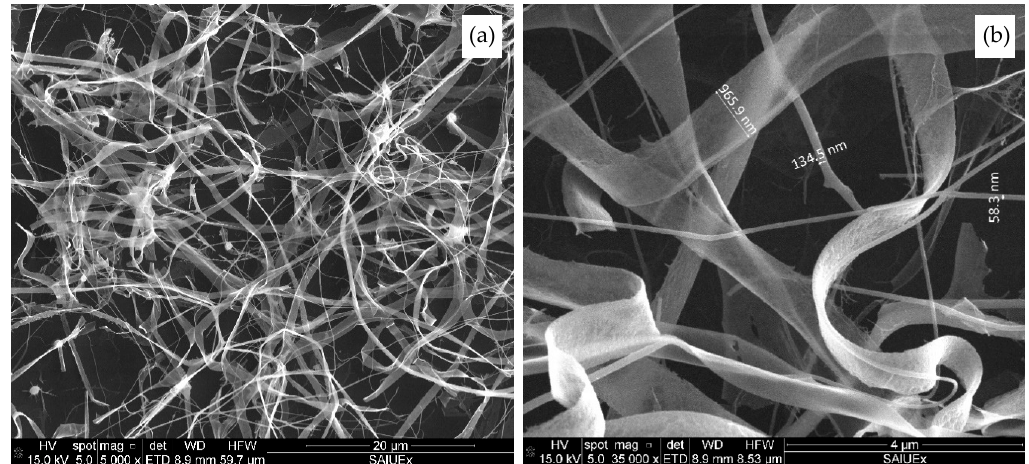
Figure 3. SEM images of tin oxide nanofibers and nanoribbons doped with PG after calcination at 450 °C. ( a ) Low and ( b ) high magnifications.